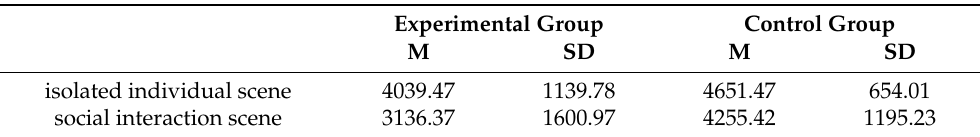
Table 2. Overall fixation duration of experimental group (autistic children) and control group (TD children) in different scenes (unit: